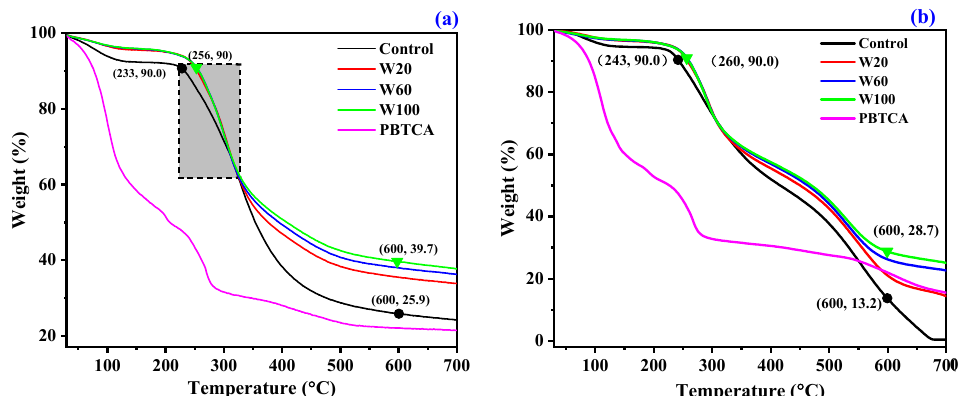
Figure 5. TG curves of the wool fabrics before and after treatment with PBTCA under nitrogen ( a ) and air ( b ) ambiance.